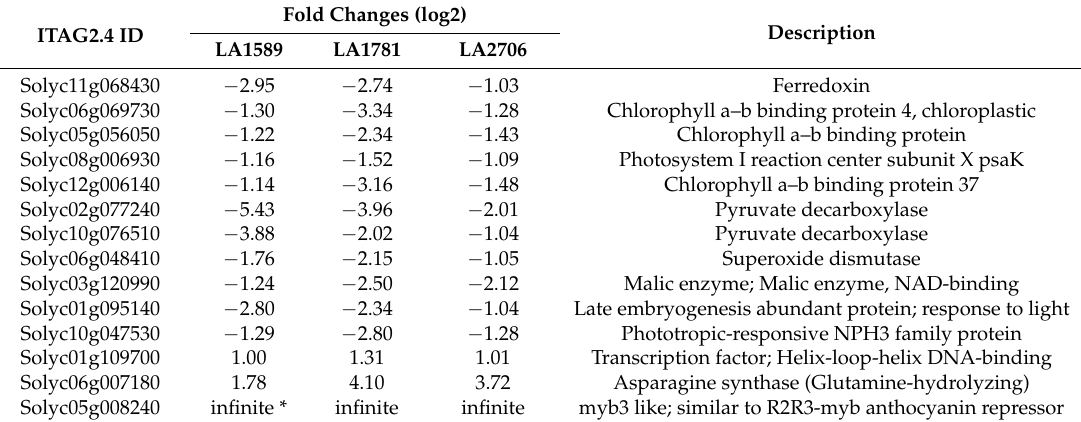
Table 1. Environmentally-sensitive genes involved in photosynthesis and light